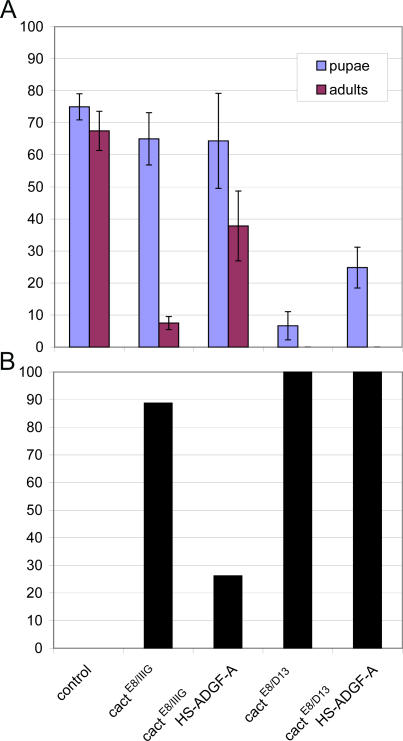
Genetic Interactions of Toll Signaling and ADGF-ASurvival rate and melanotic tumor formation were compared in mutants in the Toll signaling pathway and in similar mutants with overexpression of ADGF-A using the HS-ADGF-A construct.(A) The bar graph shows the percentage of the pupae (blue bars) and adult flies (purple bars) demonstrating the larval and pupal survival of each genotype. The x-axis shows the genotypes and is shared with (B). Flies heterozygous for the cact mutation were used as a control.(B) Percentage of late third instar larvae presenting melanotic tumor formation.